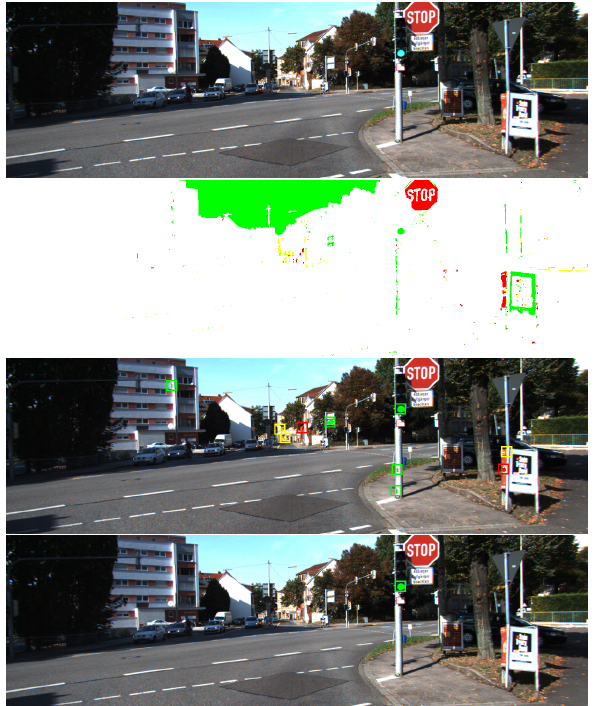
Figure 10: The traffic light detection algorithm using mono cam- era (third row) can not correctly detect the traffic light and a false positive incorrectly labeled as traffic light. The stereo cameras approach (fourth row) correctly detects the traffic light although a false positive is detected